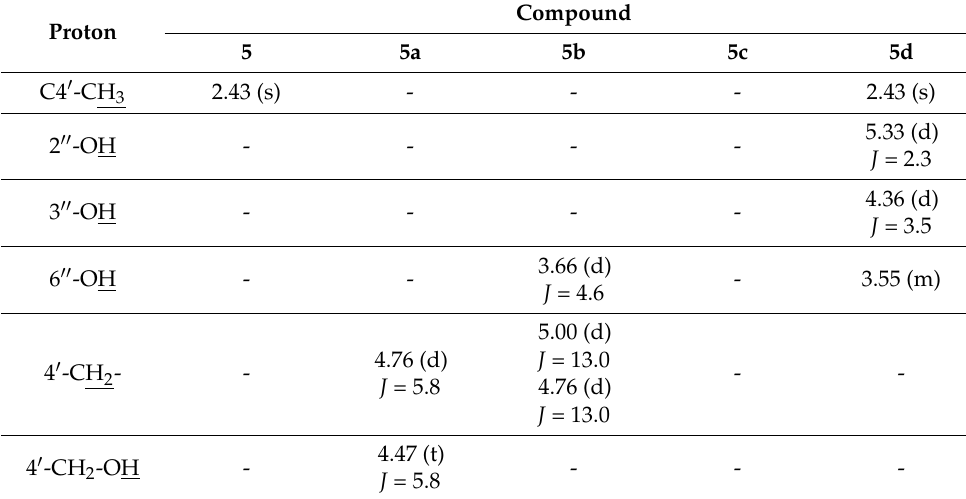
Table 4. 13 C-NMR chemical shifts δ (ppm) and coupling constants J (Hz) of 4 (cid:48) -methylflavone ( 5 ) and products of its biotransformations 5a – 5d in Acetone-d6, 151 MHz (Supplementary